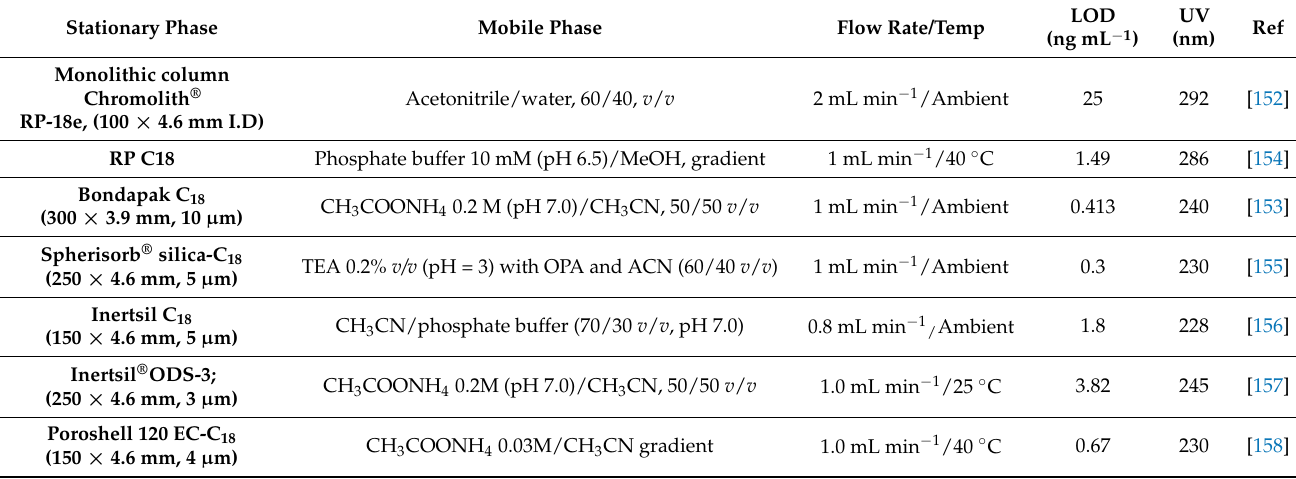
Table 4. Reverse phase chromatography and operational